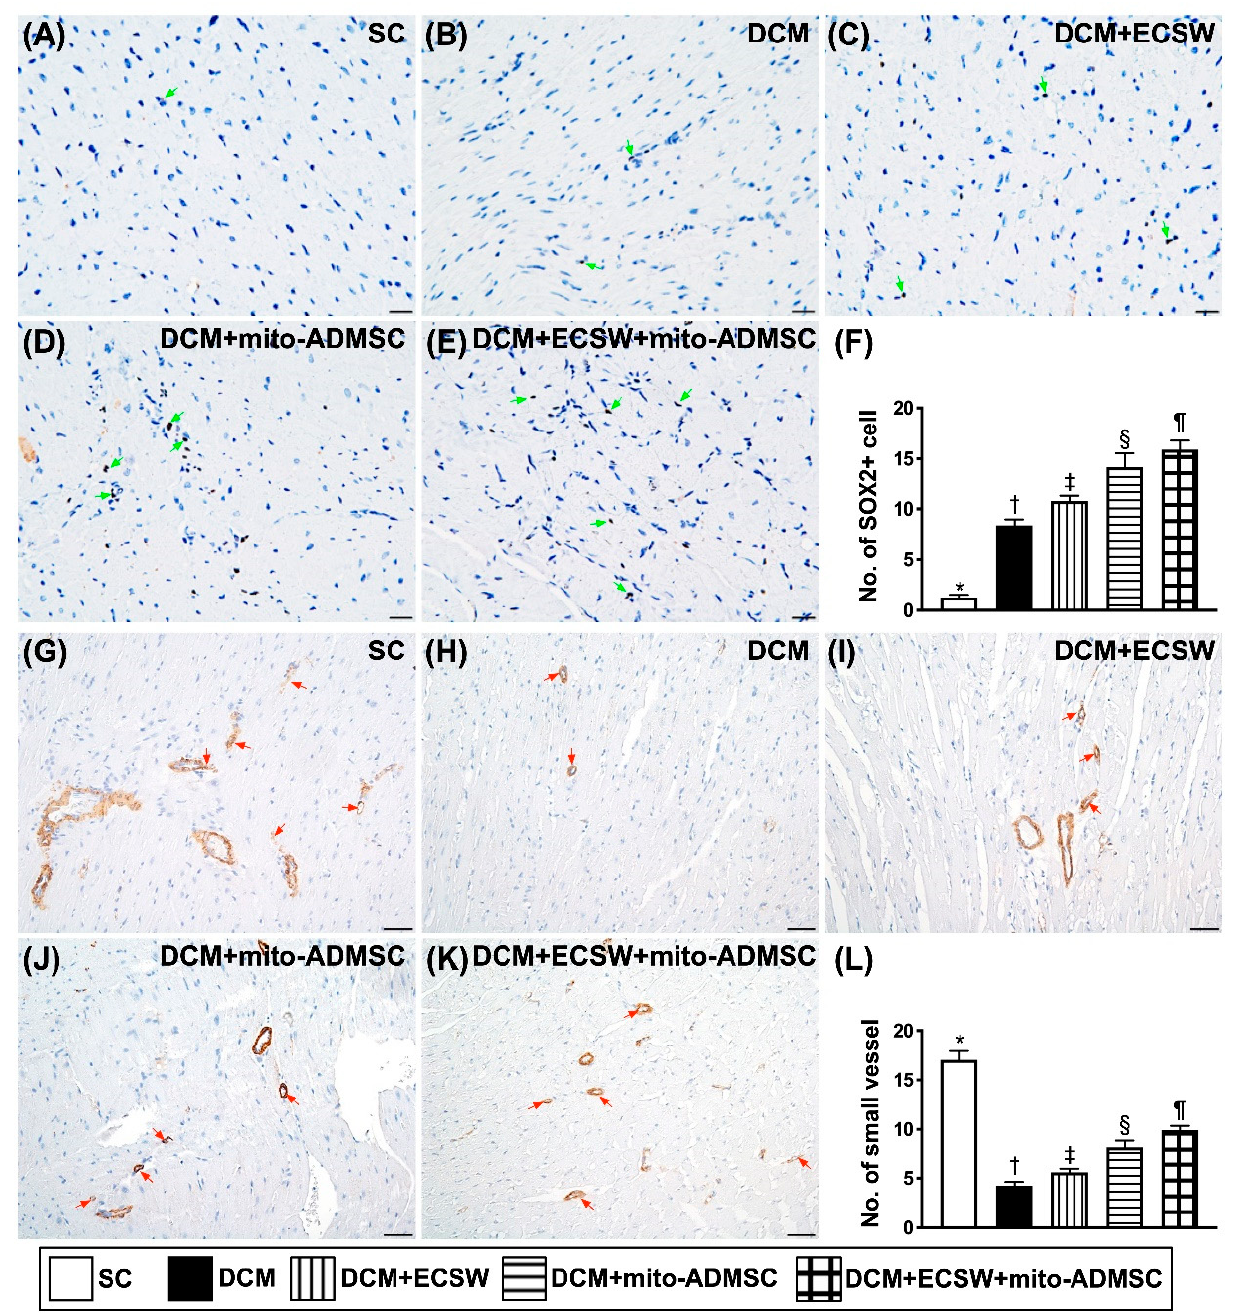
Figure 6. Pluripotency markers were upregulated by combined ECSW-assisted mitochondrial delivery into ADMSCs + ECSW therapy in LV myocardium 7 weeks after DCM induction. ( A – E ) Illustrating the microscopic finding (400 × ) for identification of cellular expression of SOX2 (gray color) (green arrows). ( F ) Analytical result of number of SOX2+ cells, * vs. other groups with different symbols (†, ‡, §, ¶), p < 0.0001. ( G – K ) Illustrating the microscopic finding (400 × ) of α -smooth muscle actin ( α -SMC) positive stain for identification of small vessel (i.e., diameter ≤ 25 µ M) density (gray color) (red color). ( L ) Analytical result of number of small vessels, * vs. other groups with different symbols (†, ‡, §, ¶), p < 0.0001. Scale bar in right lower corner represents 20 µ m for SOX2 and 50 µ m for α -SMC positive staining, respectively. All statistical analyses were performed by one-way ANOVA, followed by Bonferroni multiple comparison post hoc test ( n = 6 for each group). Symbols (*, †, ‡, ¶) indicate significance (at 0.05 level). SC = sham control; DCM = dilated cardiomyopathy; ECSW = extracorporeal shock wave; mito = mitochondria.